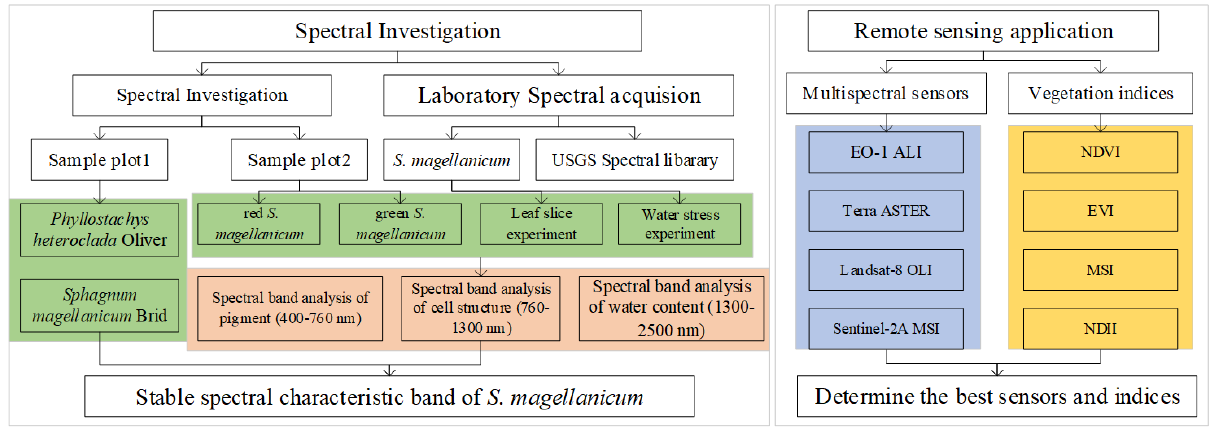
Figure 1. The research flow diagram, which consists of two parts. On the left is spectral analysis, where green rectangles represent spectral acquisition and the pink rectangle represents plant physiology-spectral analysis. On the right is remote sensing simulation, where the blue rectangle encompasses four multispectral sensors and the orange rectangle four vegetation